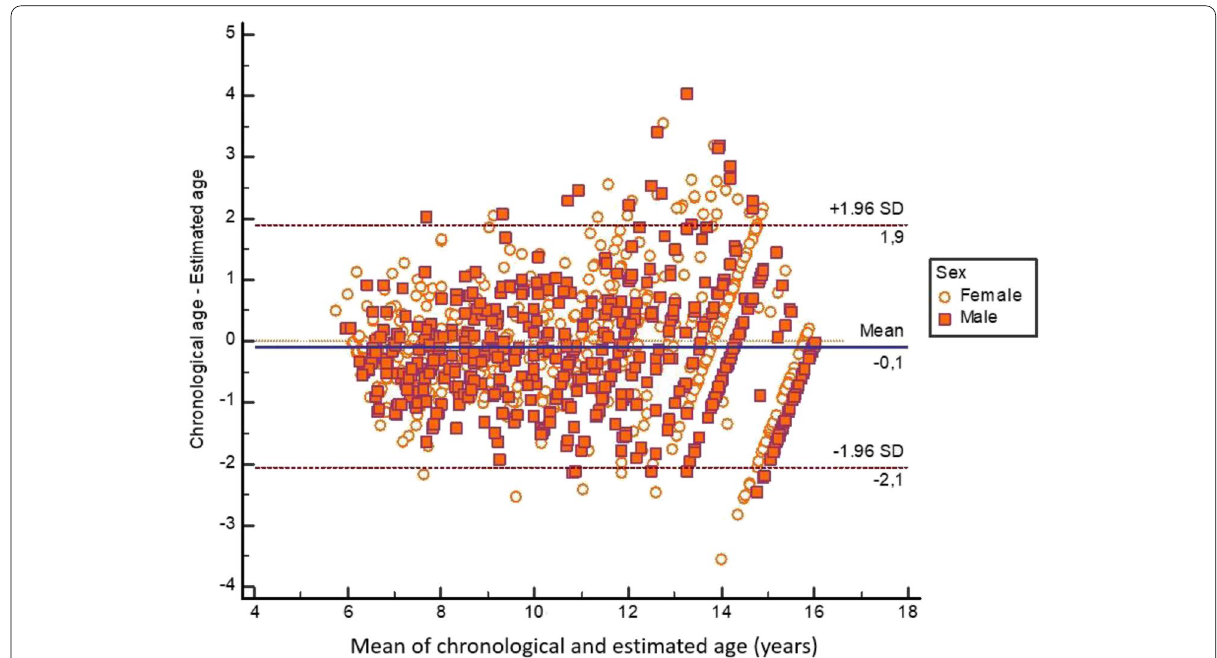
Fig. 1 Bland-Altman plot of the difference of chronological and estimated ages for females and males